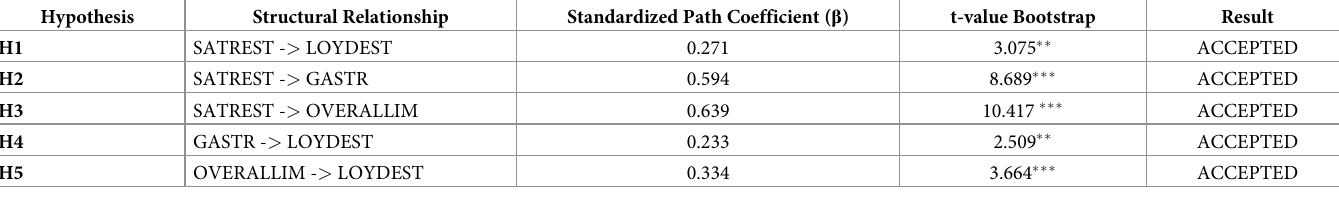
Table 6. Test of the hypotheses.